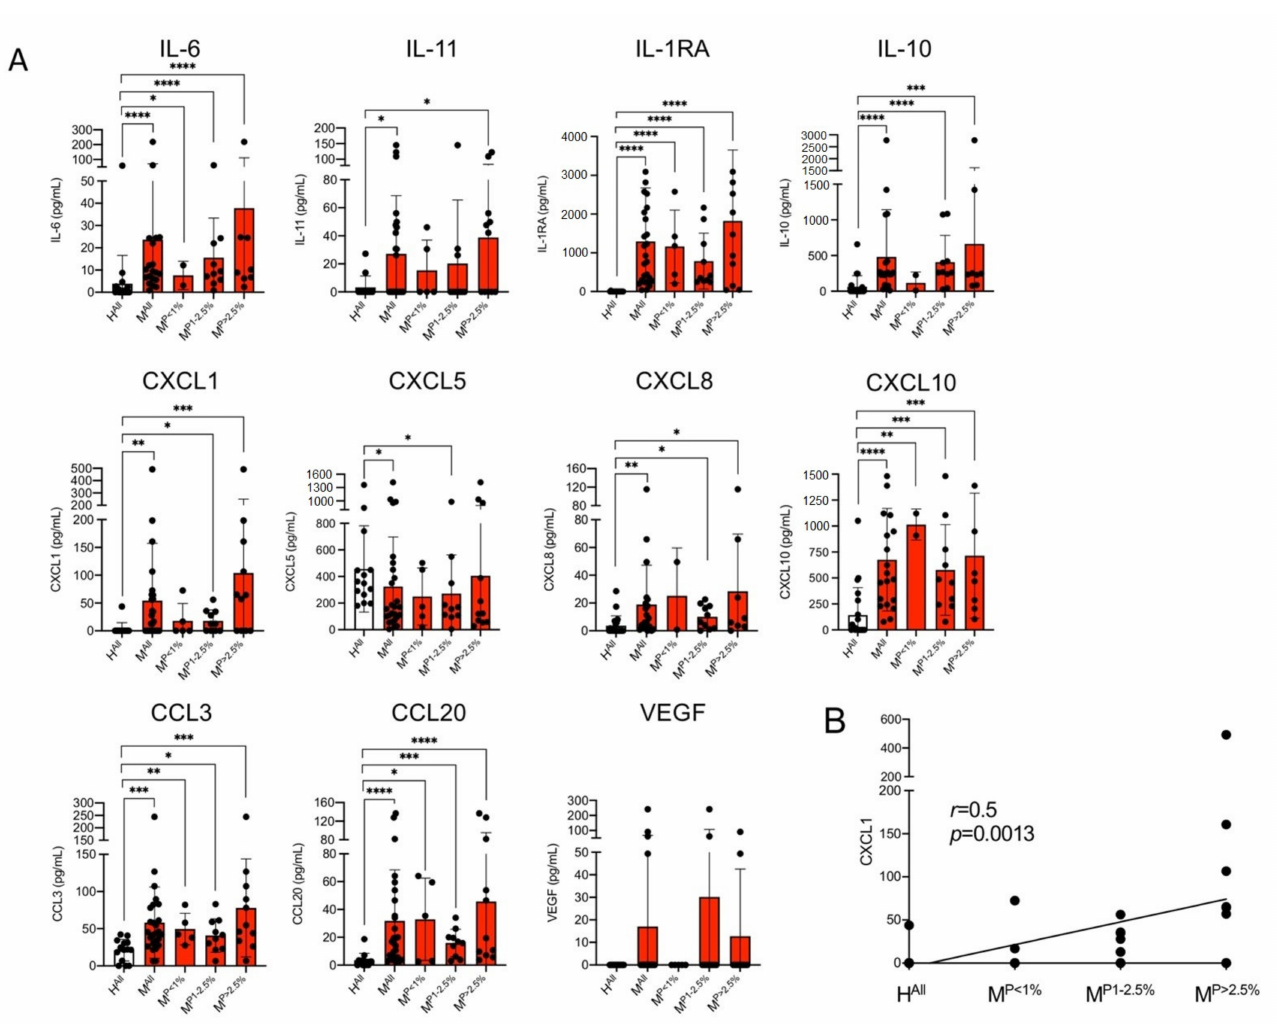
Figure 1. Levels of cytokines in plasma derived from malaria patients (M) and healthy control individuals (H). ( A ) The amount of cytokines was measured with a bead-based LEGENDplex assay ( n = 13–26, Supplementary Tables S2 and S3). Data are expressed as the mean ± standard deviation (SD). Statistical analyses were performed using the Mann–Whitney U test (* p < 0.05; ** p < 0.01; *** p < 0.001; **** p < 0.0001). ( B ) For CXCL1, the correlation between the amount of cytokine and parasitaemia was performed by means of a nonparametric Spearman correlation using GraphPad Prism (version 9.0.2 (134)). Abbreviations: Healthy controls (H All ); malaria patients (M All ); malaria patients with a parasitaemia < 1% (M P<1% ), 1–2.5% (M P1 − 2.5% ) and >2.5% (M P>2.5%